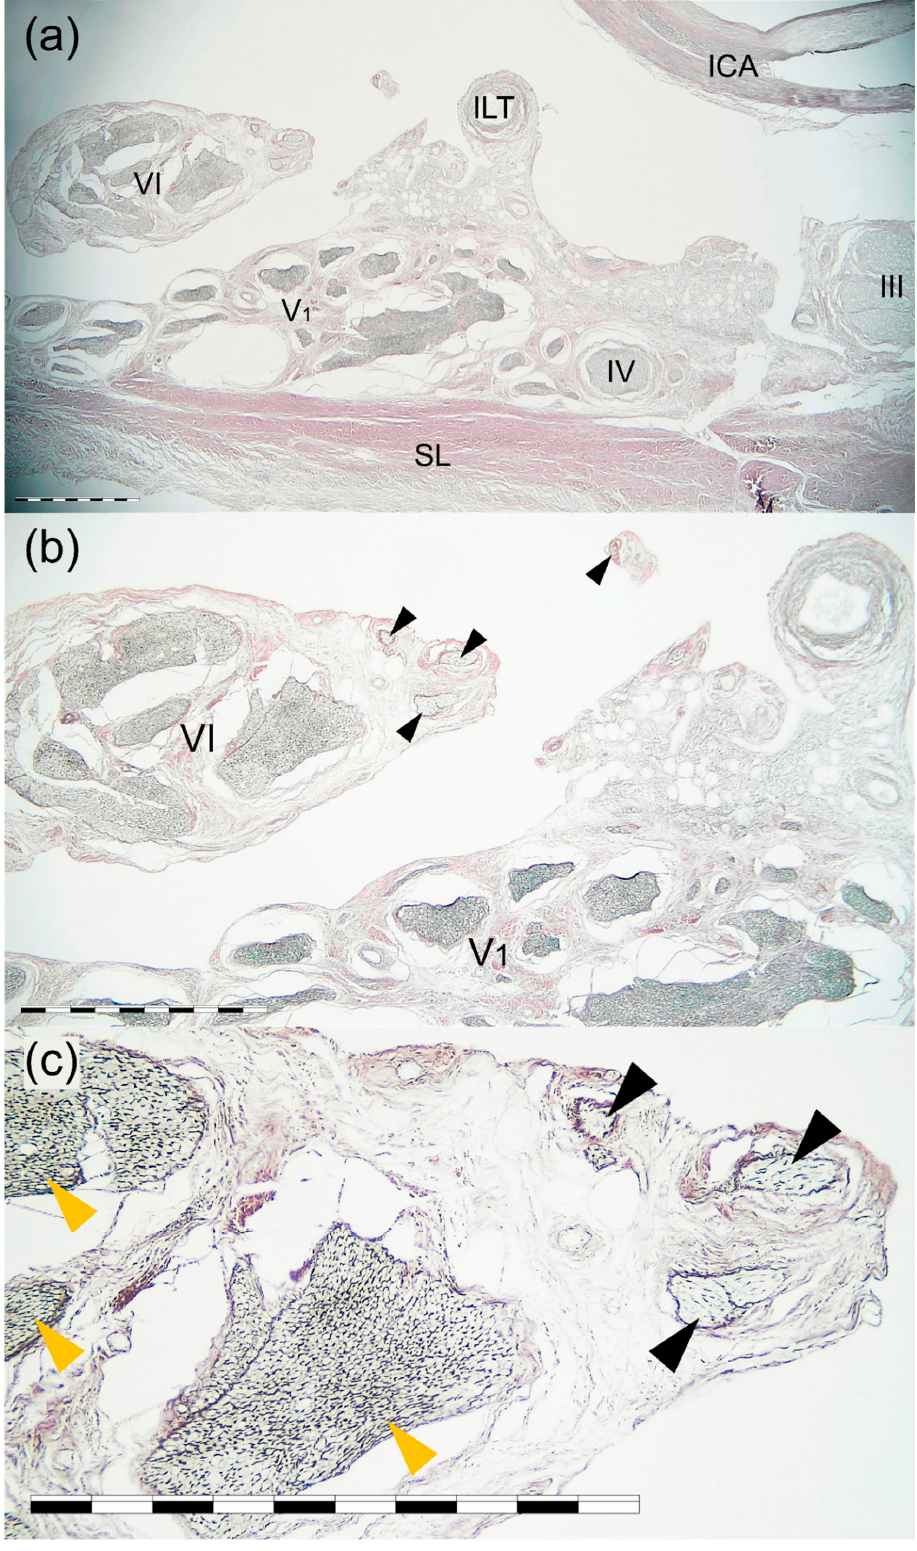
Figure 5. Cross-section of the AN, lateral wall of the cavernous sinus, and the horizontal portion of the cavernous part of the ICA. Silver staining according to Gordon and Sweet’s method. ( a )